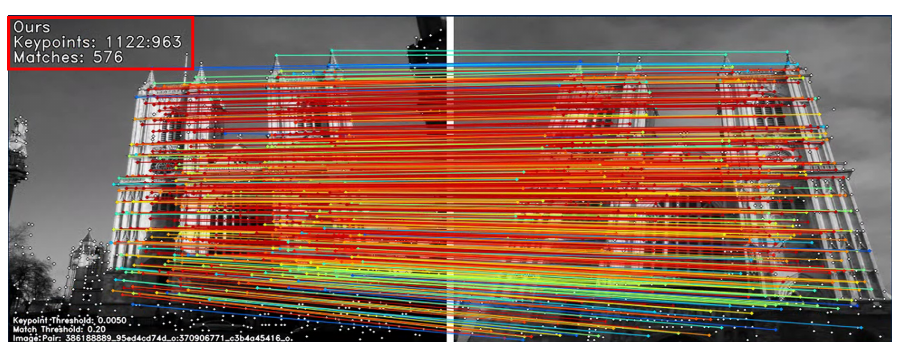
Figure 1. Visualization of different methods. For the same image pairs, we use three different methods to visualize the effect. subfigure ( a ) represents SIFT + NN, SIFT is a hand-craft feature, subfigure ( b ) represents SuperPoint + SuperGlue, SuperGlue is a learning-based matcher, and subfigure ( c ) is SuperPoint + GFM, which is our proposed method. The number of keypoints and the number of matching pairs are marked in the upper left corner of all images using red rectangular boxes. Comparing subfigure ( a ) and subfigure ( c ), we can see that our method can obtain more dense and robust matching pairs compared to traditional matching. Comparing subfigure ( b ) and subfigure ( c ), we can see that our method is more advantageous in obtaining the number of correct matching